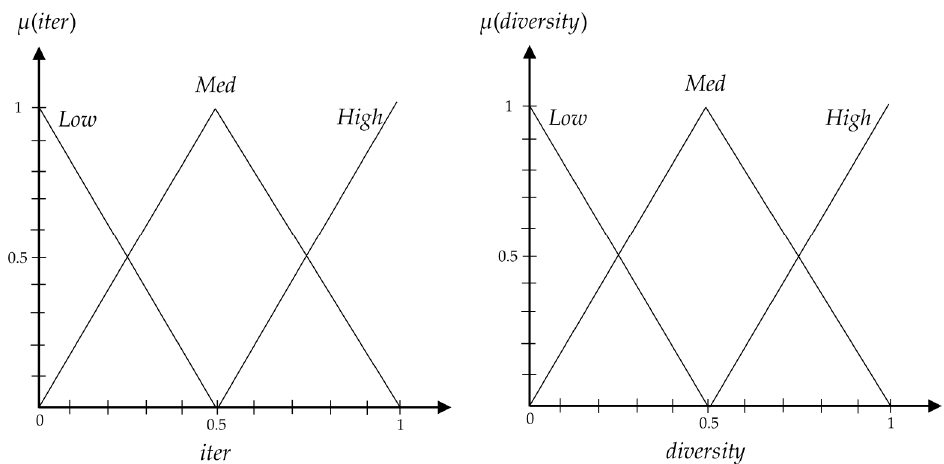
Figure 3. Input membership functions of the proposed fuzzy inference system.